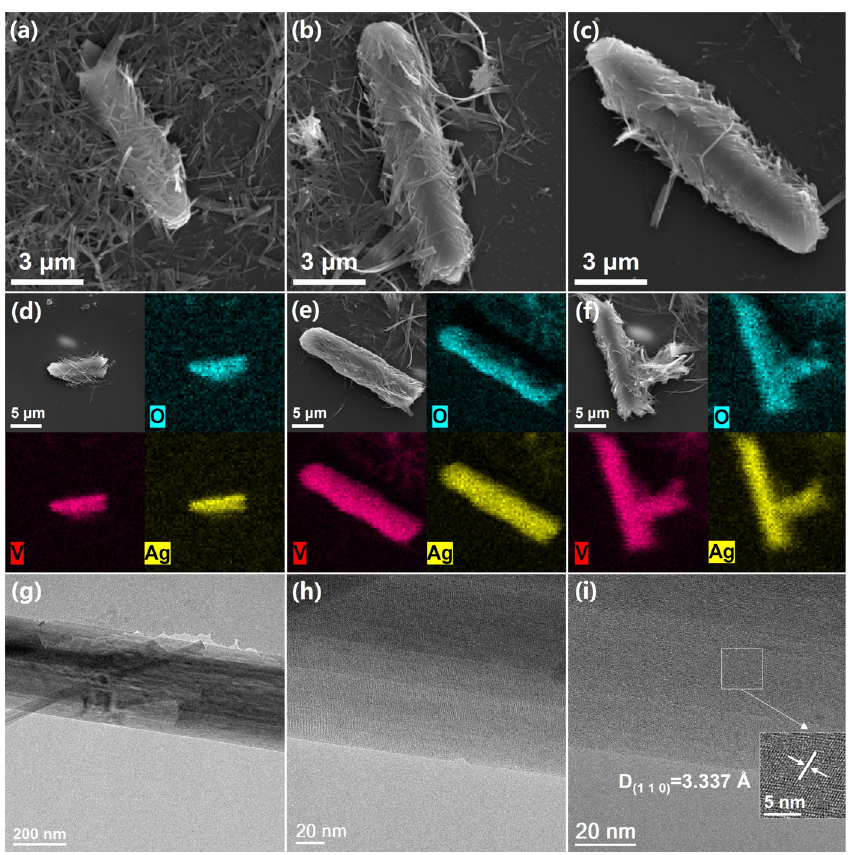
Figure 2. SEM images of Ag2V 4 O 11 -160 ( a ), Ag 2 V 4 O 11 -180 ( b ) and Ag 2 V 4 O 11 -200 ( c ); elemental map- ping images for Ag 2 V 4 O 11 -160 ( d ), Ag 2 V 4 O 11 -180 ( e ) and Ag 2 V 4 O 11 -200 ( f ) showing the presence of O, V, and Ag; TEM images at different magnifications ( g , h ) and HRTEM image of Ag 2 V 4 O 11 -180 (i).